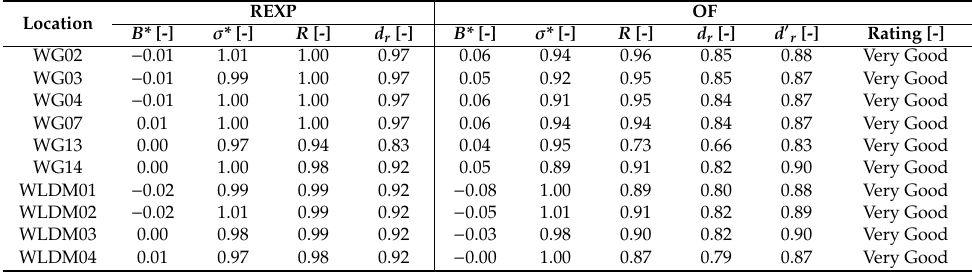
Table 3. Pattern and model performance statistics for all η measurement locations.